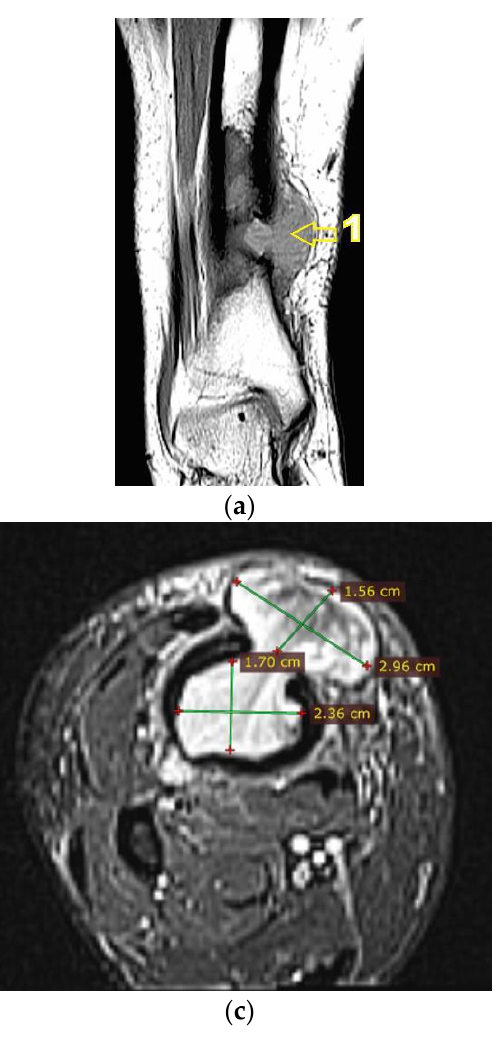
Figure 6. ( a ) MRI T1 hyposignal coronal section. 1 — extraosseous expansion of the tumor formation;